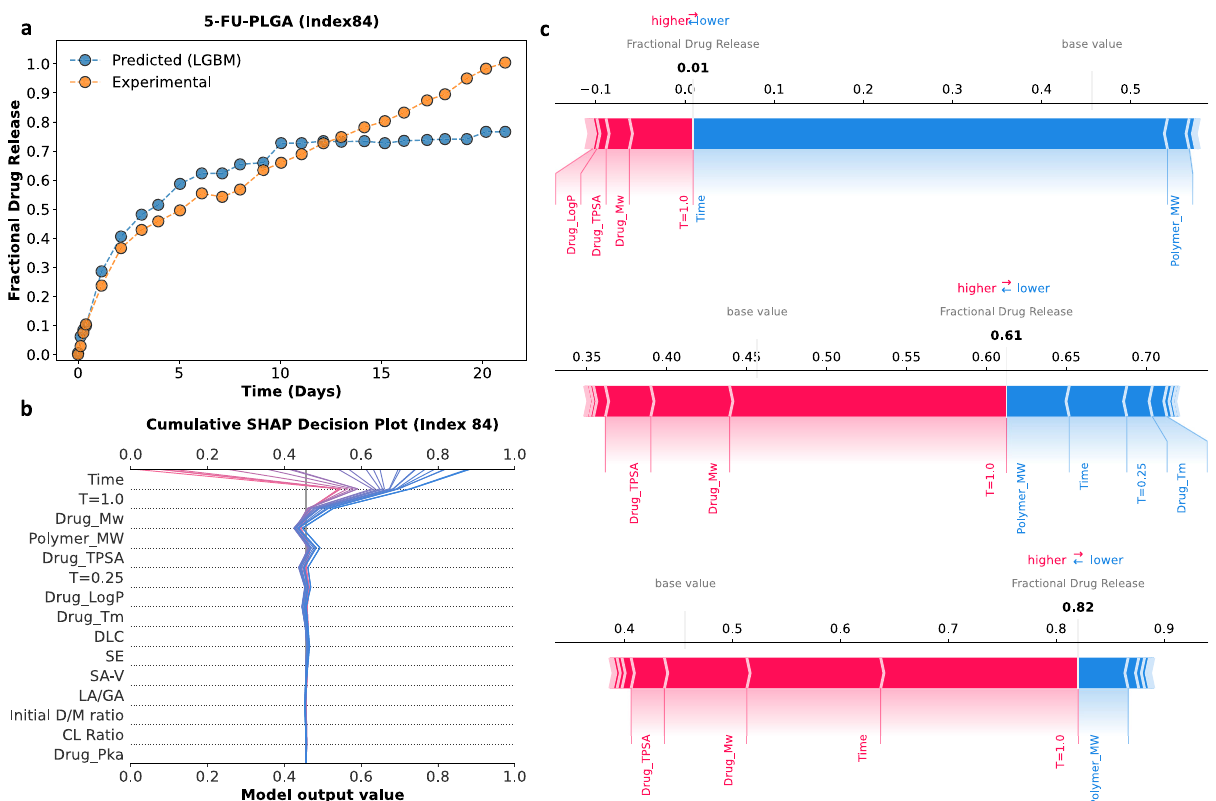
Fig. 5 | A visual representation of how the 15-feature LGBM model generates fractional drug release predictions using the example of 5-FU-PLGA (index 84 in the attached dataset). a Experimental fractional drug release pro fi le (orange circles) for 5-FU-PLGA plotted against the predicted fractional drug release pro fi le (blue circles) generated by the LGBM model. b Decision path taken for each frac- tional drug release prediction for the 5-FU-PLGA system. This plot illustrates how theLGBMmodelcombinestherelativecontributionofeachinputfeaturetoreturn thepredictedfractionaldrugreleasevalue. c Shapleyadditiveexplanations(SHAP)